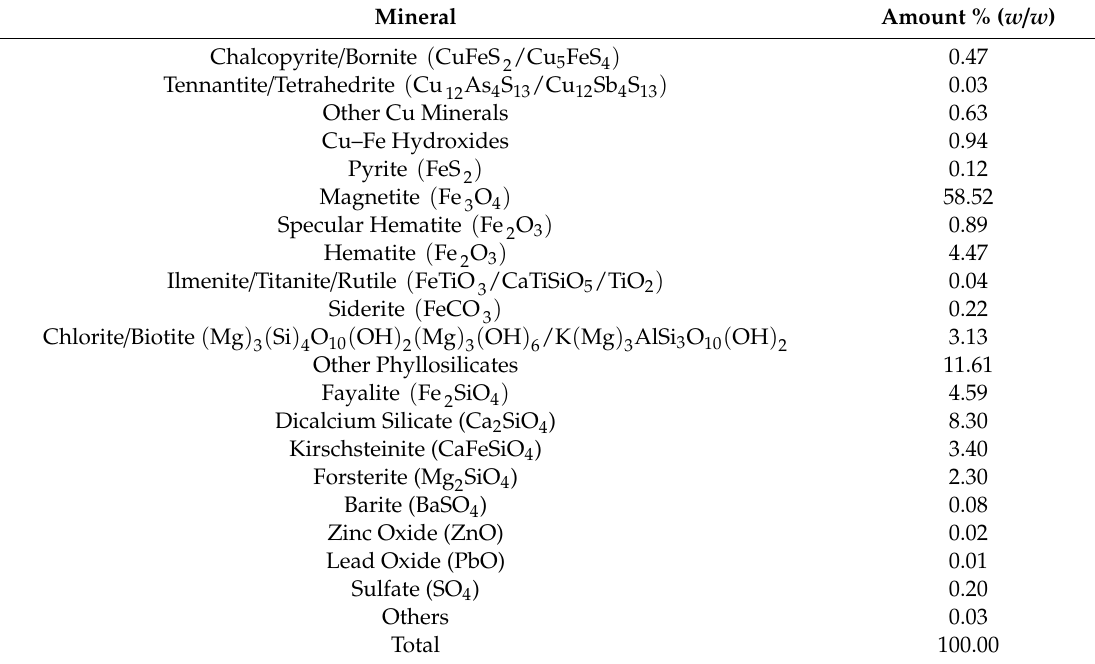
Table 3. Mineralogical composition of tailings, as determined by